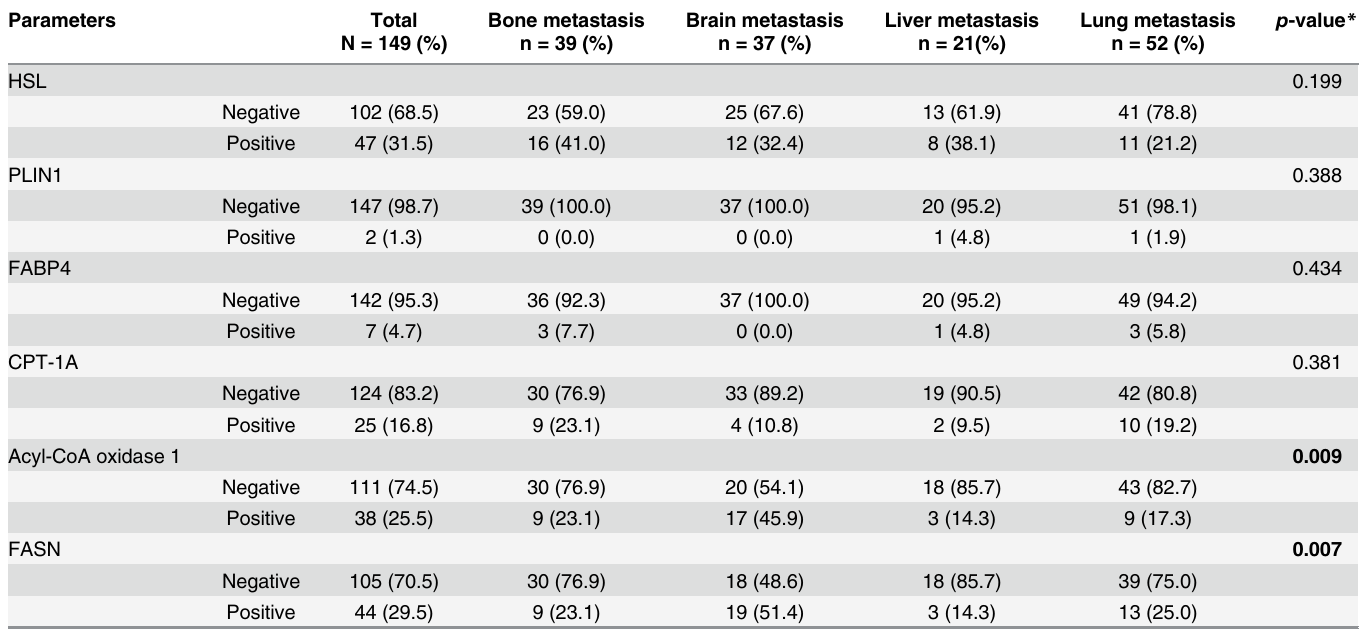
Table 3. Expression of metabolism-related proteins in the tumor cell compartment of breast cancer metastases according to metastatic site.